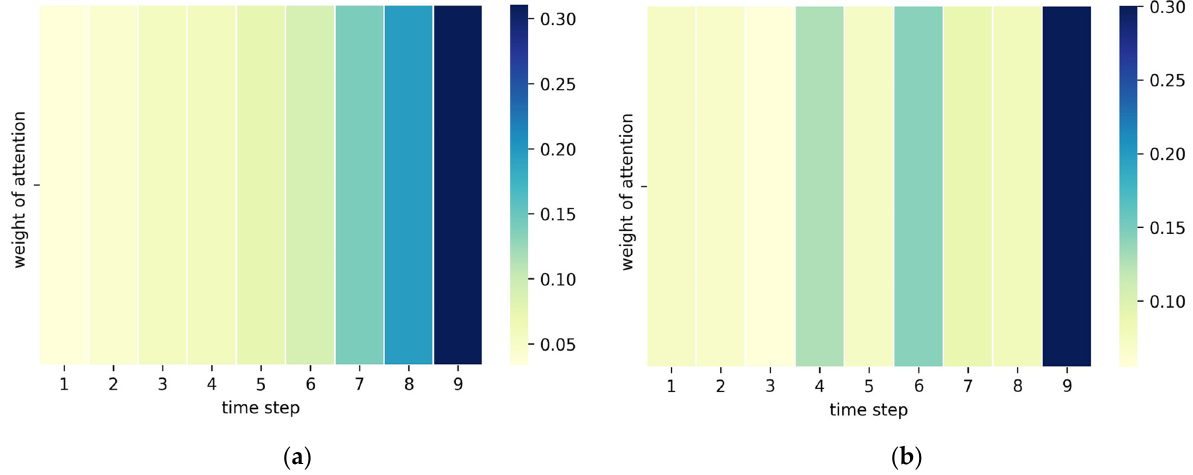
Figure 14. Heat map of attention weight: ( a ) the attention mechanism is coupled before LSTM and ( b ) the attention mechanism is coupled after LSTM.